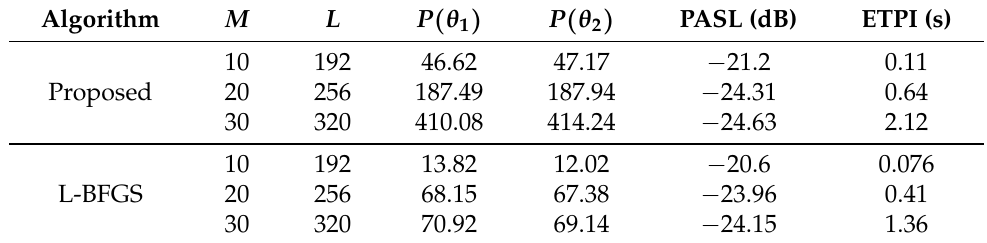
Table 3. The performance of each algorithm in the orthogonality design of